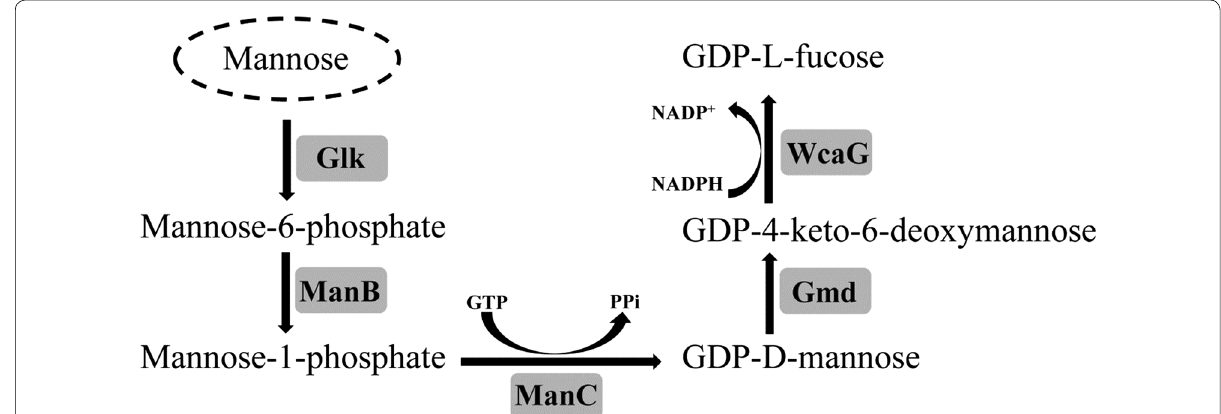
Fig. 1 De novo biosynthetic pathway of GDP- l -fucose. Glk glucokinase, ManB phosphomannomutase, ManC mannose-1-phosphate guanyltransferase, Gmd GDP- d -mannose-4,6-dehydratase, WcaG